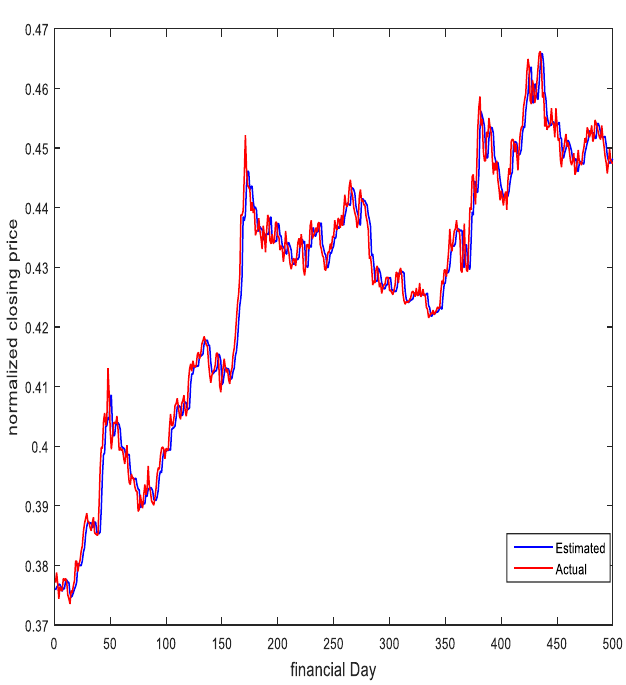
Figure 8 . Actual v/s estimated closing prices by combined method (error base) from FTSE